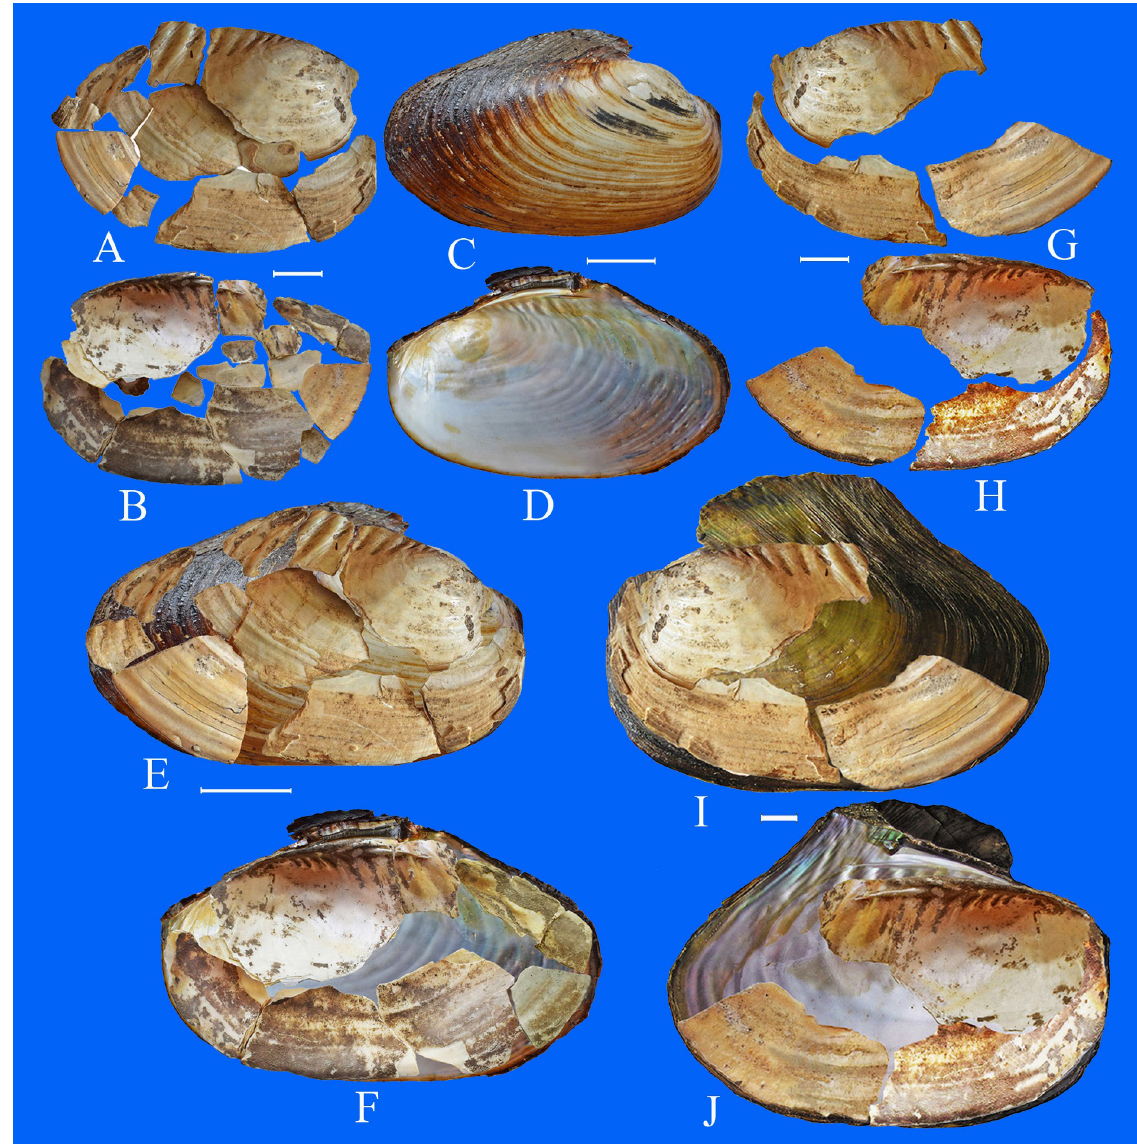
Fig 6. Archaeological specimens and recent shells of Cristaria . A, B –fragments of shell valves (views of the outside and inside) from archaeological excavation in the Bol’shaya Kanga, G-H–shell fragments of Cristaria from excavation in Luzhanki ancient settlement; C, D– recent C . plicata (view of the outside and inside of the shell) from the Shilka River; E-F–shell fragments from excavation in the Bol’shaya Kanga, superposed with a recent shell of C . plicata from the Shilka River; I-J–shell fragments of Cristaria , superposed with recent shell of C . plicata from the Onon River Basin. Scale bar 2